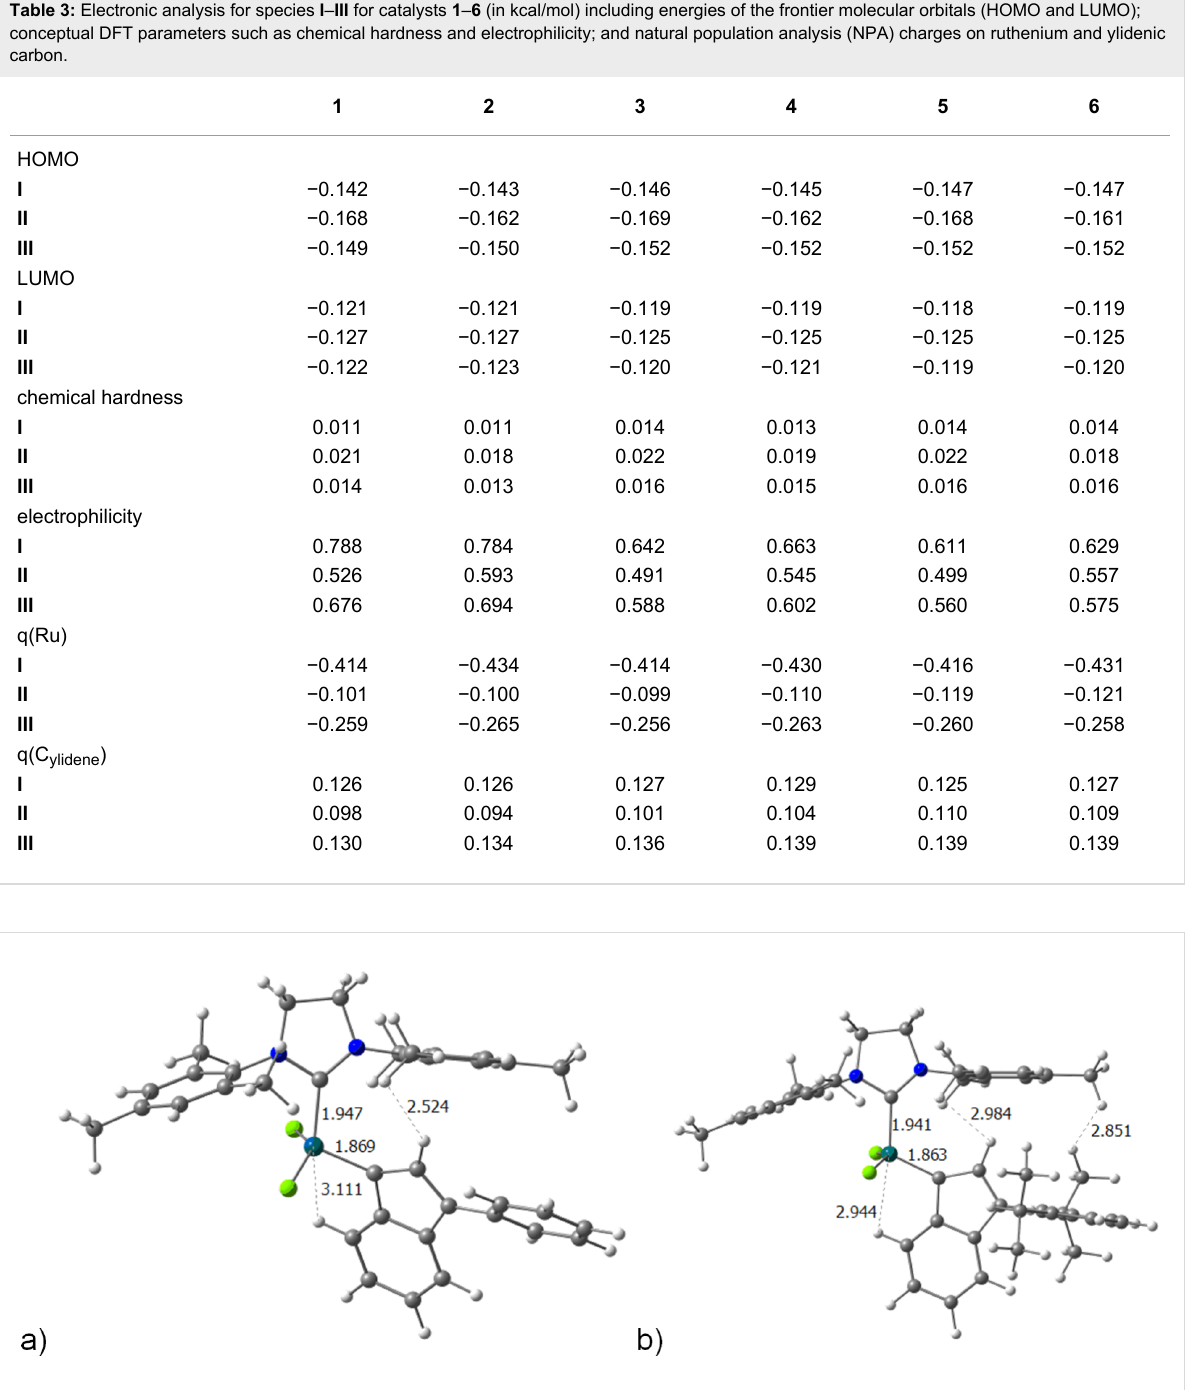
namically, the next metallacycle IV is also favoured with the indenylidene substitution, being 4.2 and 3.4 kcal/mol relatively more stable for systems 3 and 5 , respectively, with respect to 1